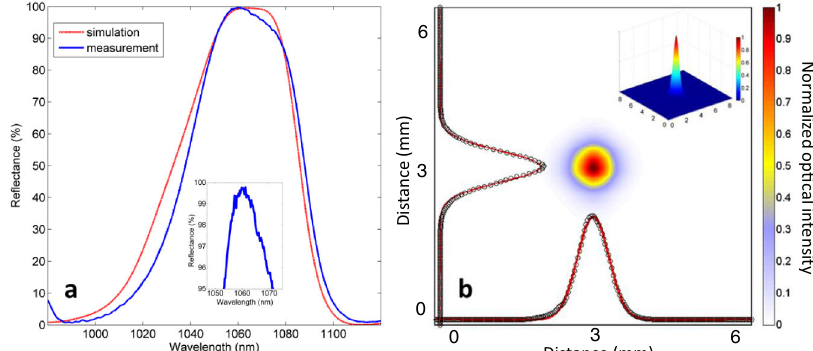
Fig. 3 Optical characterization of a diamond mirror. a Re fl ection spectrum of a diamond mirror, blue line is measurement data and red line is FDTD simulation. Absolute re fl ectivity of 98.9 ± 0.3% is measured at 1064 nm using a DBR laser. Inset shows a zoom-in of the measured spectrum around its maximum. b Beam pro fi le measurement taken of the re fl ection from the diamond mirror using a scanning-slit pro fi ler. Axes show cross sections of the re fl ected beam (black circles) with overlaid Gaussian fi t (red). Fit yields a 4 σ beam width of ~1.5 mm. Distance refers to the amount traveled by the slit relative to its initial position. Inset shows a 3-D perspective of the re fl ected beam, with axes (and its units) identical to the main fi gure. Colors indicate normalized optical